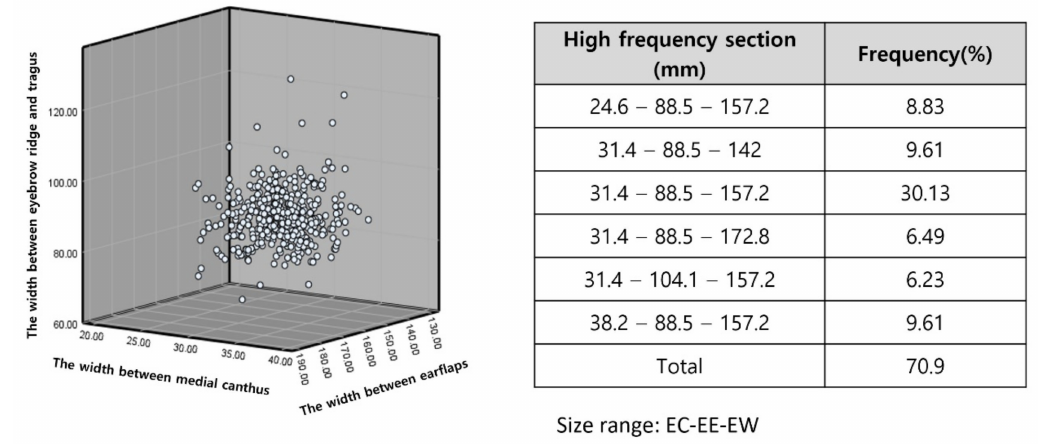
Figure 2. Distribution of sizes with high frequencies.